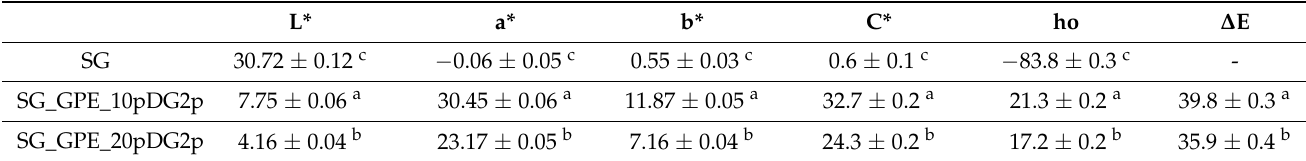
Table 5. Spectrophotometric data of the cosmetics with GPE_10pDG2p and GPE_20pDG2p obtained by D65.